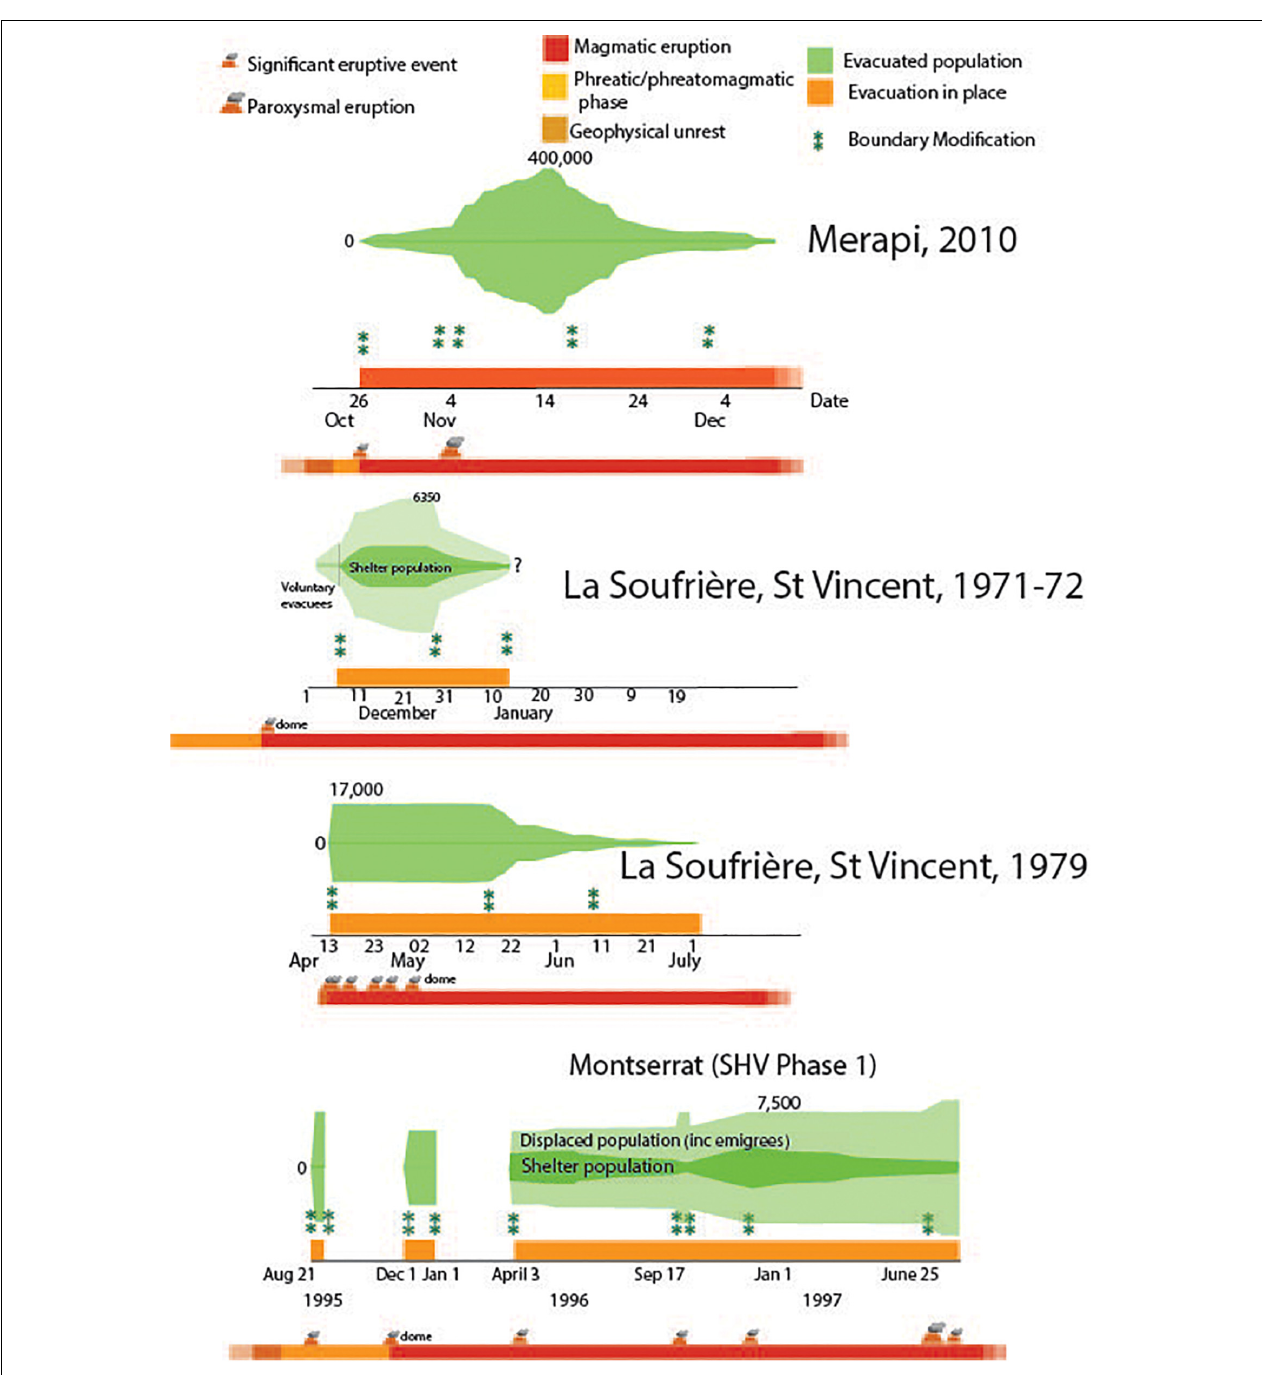
FIGURE 2 | Details of pattern of evacuation and population in shelters for Montserrat, St. Vincent and Java during the eruptions of Soufrière Hills, Soufrière and Merapi respectively. Data on shelter numbers is as follows St. Vincent (1979)-FCO44/2030 and 2031(54) (1971), FCO63/882, 883(55) and 1022, Montserrat Clay et al. (1999). Merapi is from Mei et al. (2013). Fatalities at Montserrat were due to the paroxysmal eruption of 25 June 1997. Fatalities at Merapi were caused both by the rapid-onset eruption (October 26) and the later paroxysm (November 4–5,